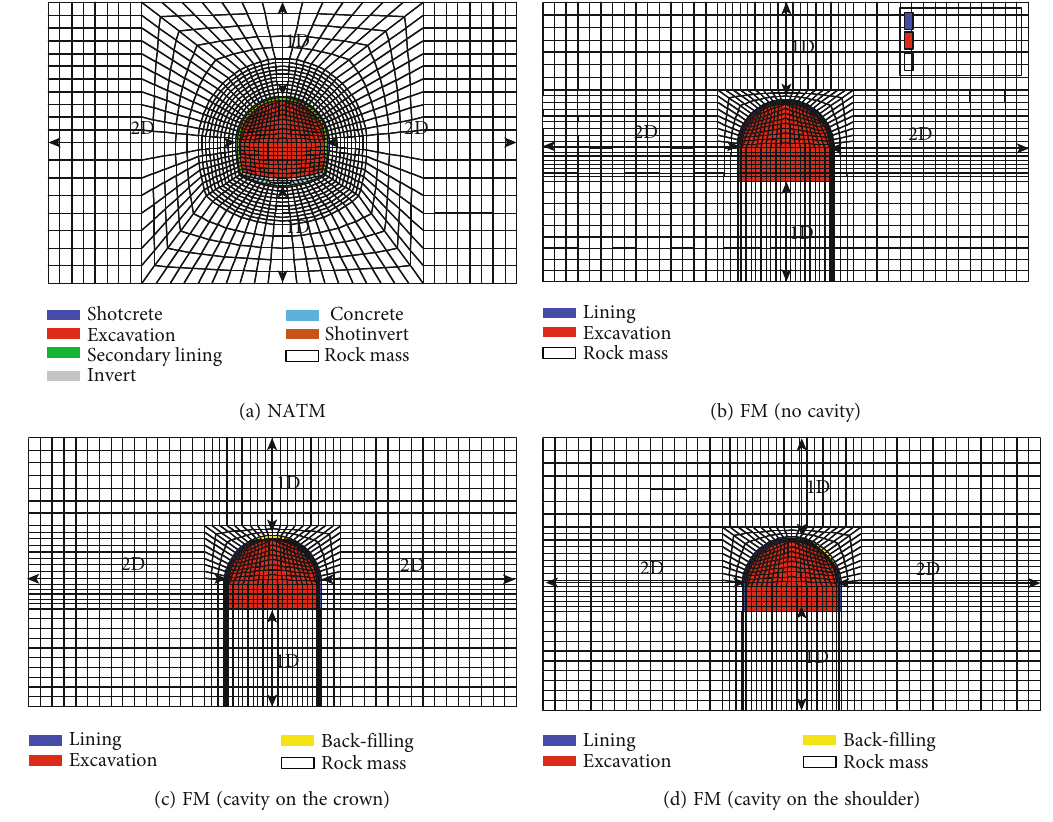
Figure 2: Numerical modelling setup.